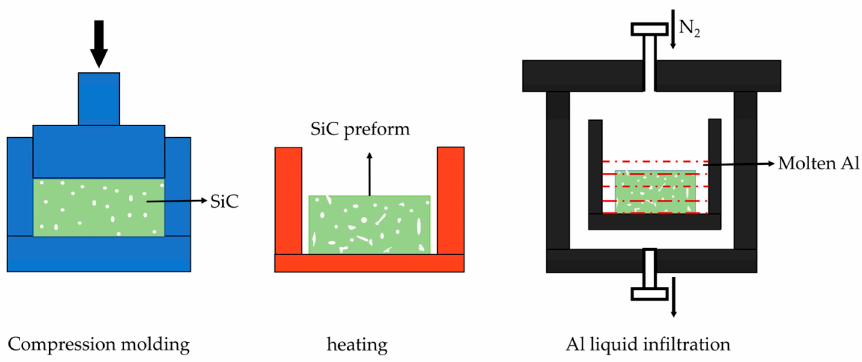
Figure 1. Illustration of the preparation of high-volume fraction SiC/Al by the liquid infiltration method.